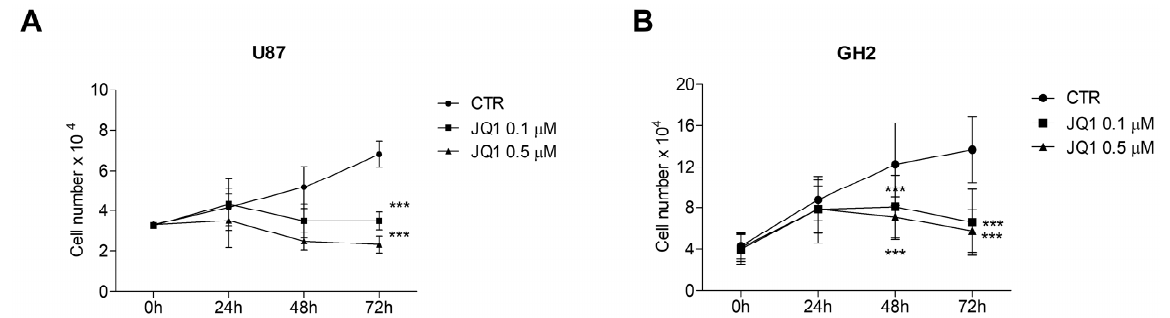
Figure 2. BET protein inhibition leads to cell proliferation arrest and G1 accumulation. U87 ( A ) and GH2 ( B ) cells were cultured in complete DMEM (0 h) or in the presence of 0.1 or 0.5 µ M of JQ1. At the indicated time points, the cells were trypsinized and counted in a Thoma chamber. The graph represents the means ± SEMs of three different experiments. Statistical significance: *** p ≤ 0.001, two-way ANOVA.